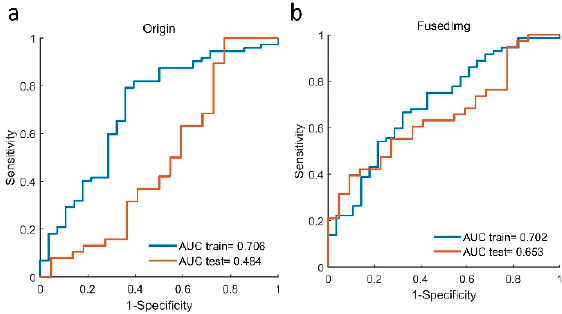
Figure 5. AUC value of HPV status prediction for ( a ) Origin model and ( b ) FusedImg model in both training and testing cohorts with 100 and 60 patients, respectively.